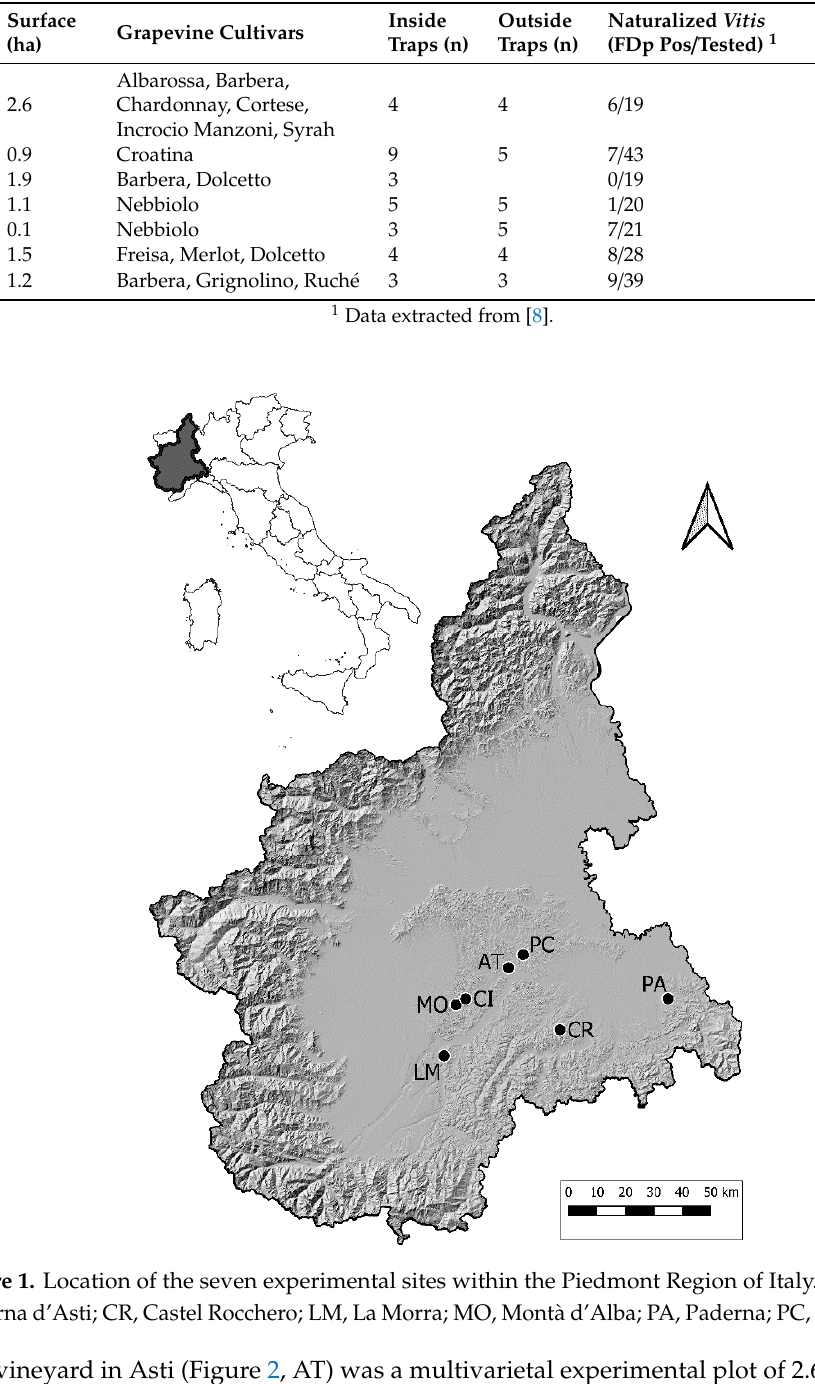
Table 1. Main characteristics of the seven vineyards.